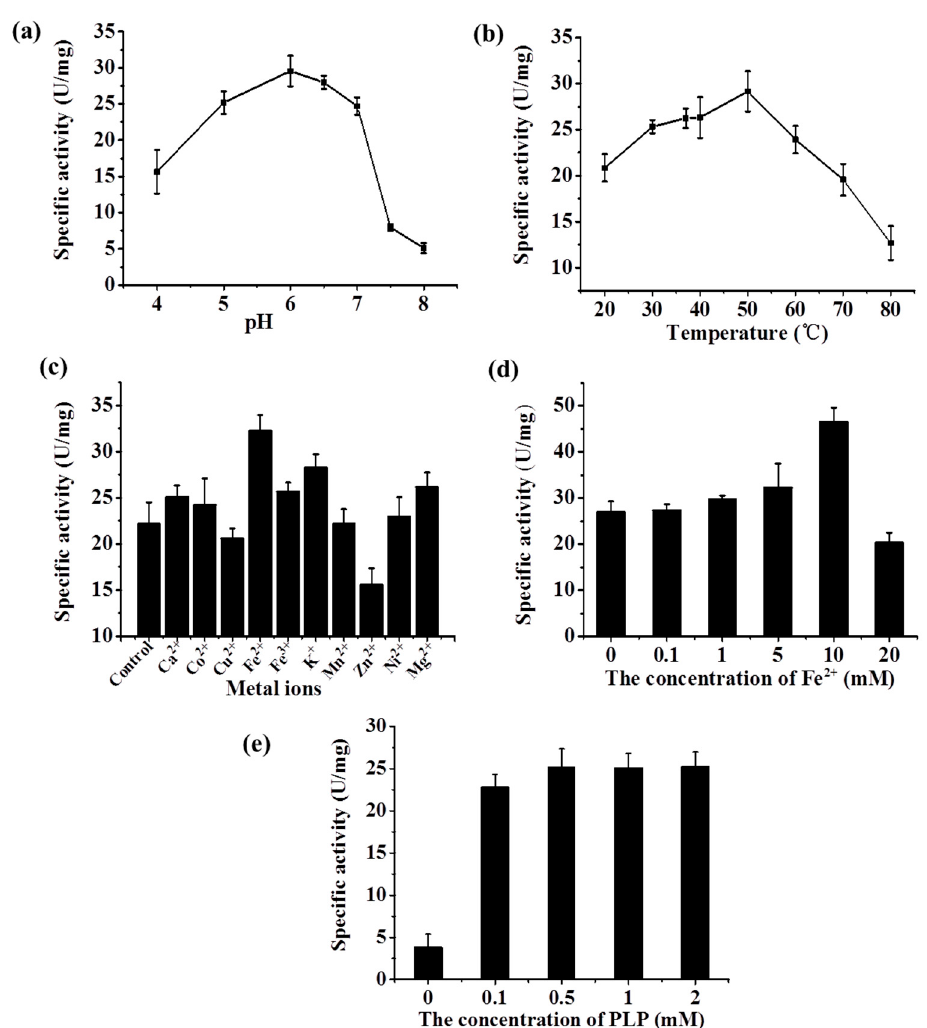
Figure 5. Characterization of the recombinant lysine decarboxylase. ( a ) Optimal pH of the recombinant lysine decarboxylase; ( b ) optimal temperature of the recombinant lysine decarboxylase; ( c ) metal ion preference of the recombinant decarboxylase; ( d ) optimization of the concentration of Fe 2+ ; ( e ) optimization of the concentration of pyridoxal 5 ′‐ phosphate (PLP). Data are mean ± SD for three replicates.